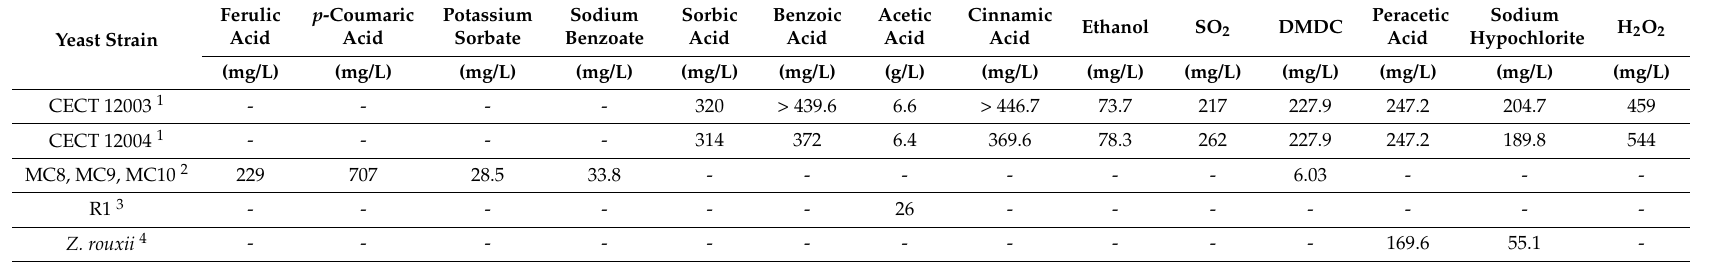
Table 1. Minimum inhibitory concentration of preservatives and disinfectants against Zygosaccharomyces rouxii